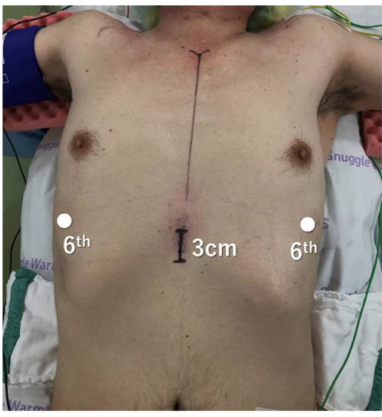
Figure 2. Port placement for three-arm robotic thymectomy using the subxiphoid approach. The patient was placed in the supine position and the chest was lifted up by a pillow under the back. The both arms were abducted so as not to interfere with the movement of the robotic arms, and the legs were not opened. The surgeon stood on the right side of the patient, and the endoscopist stood on the left side. A 3 cm vertical incision was made below the xiphoid process. After dividing the linea alba, the attachment of the rectus abdominis was dissected away from the xiphoid process, and the posterior surface of the sternum was blindly detached using the finger. A 4-channel glove port was inserted, and CO 2 insufflation was performed. The bilateral mediastinal pleura was incised using electrocautery, and the surrounding area was further dissected until there was sufficient space between the sternum and pericardium. Two additional robotic ports were inserted bilaterally at the sixth intercostal space along the anterior axillary line. One of the subxiphoid ports was used as an assist port. If the 4-arm subxiphoid approach is performed, then an additional robotic port is inserted at the right sixth intercostal space along the mid-axillary line. Most reports of subxiphoid approach have been performed with the legs open [29,30], but these preparations can be performed without opening the